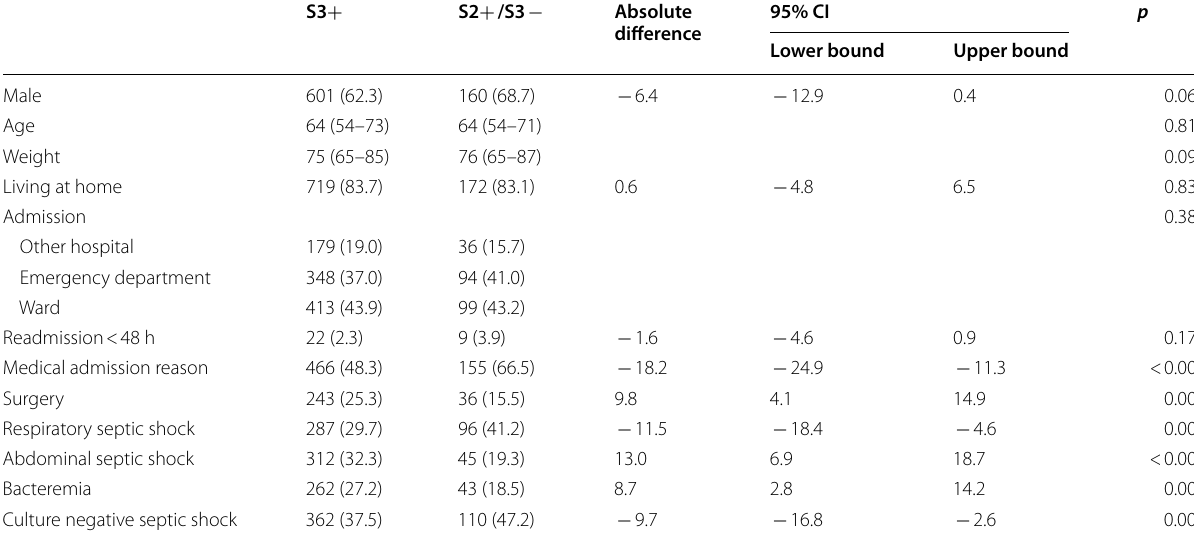
Fig. 1 Patient selection Table 1 Baseline characteristics of the study population